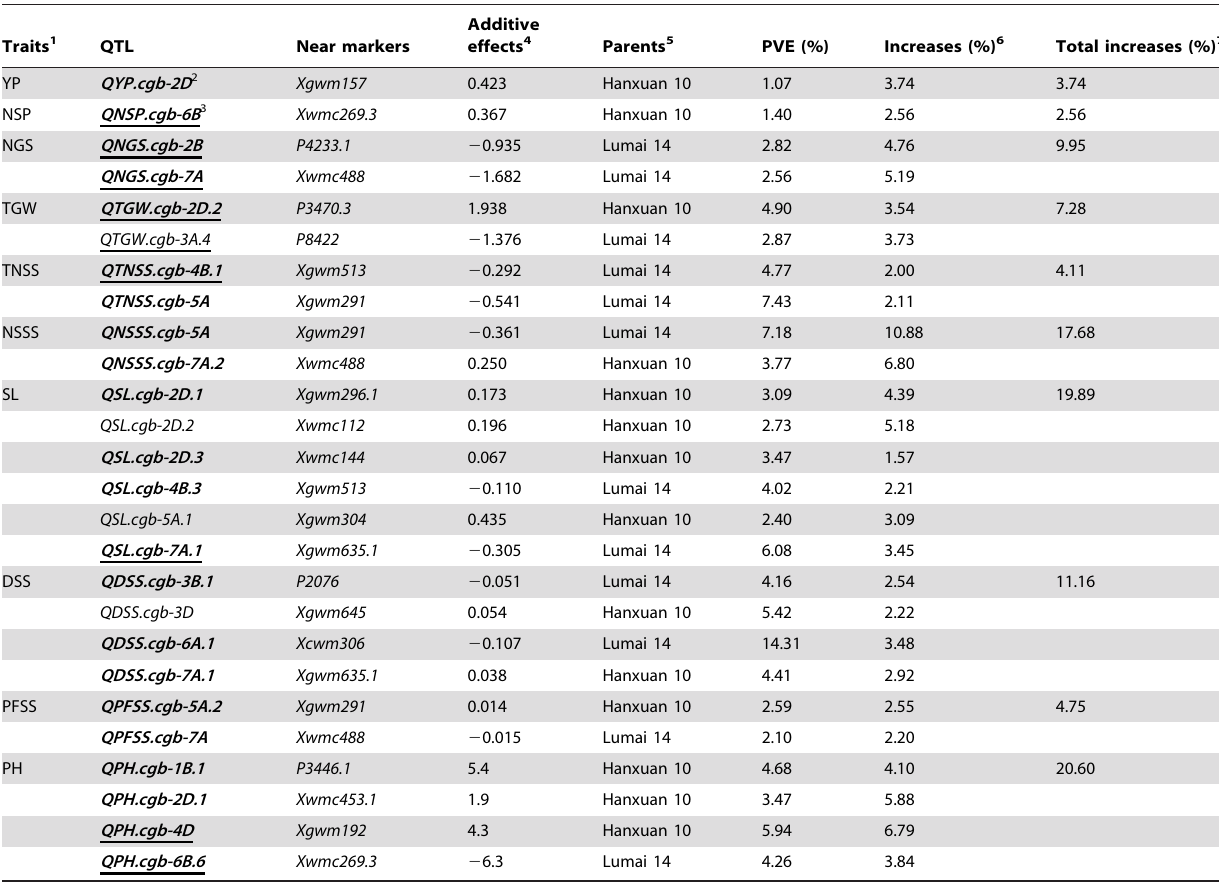
Table 8. Major QTLs in wheat DH